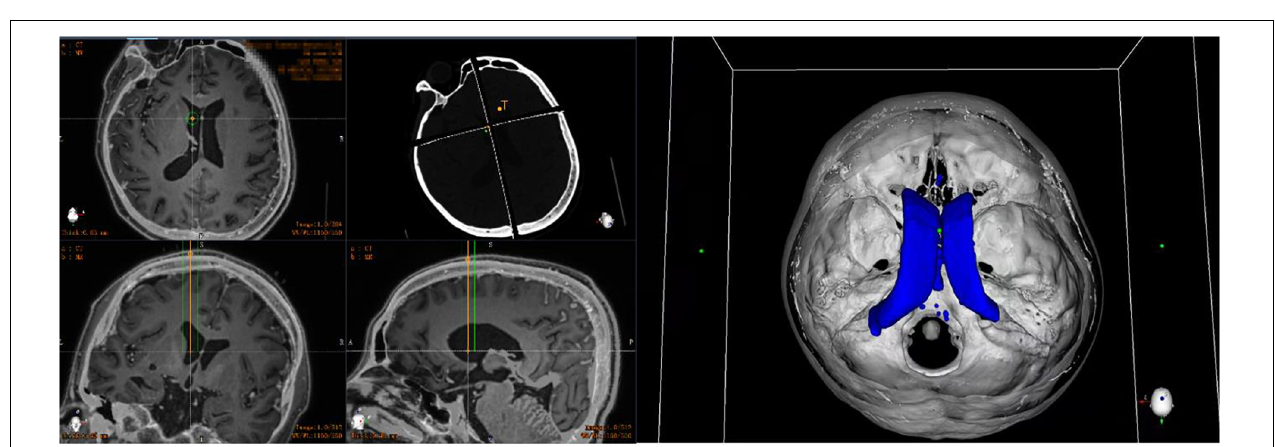
FIGURE 1 | Videometric-tracked marker: it was capable of automatic patient-to-image registration, was adhered to the scalp in the preoperative and accompanied the patient for a CT scan; detected optical frame marker during surgery.